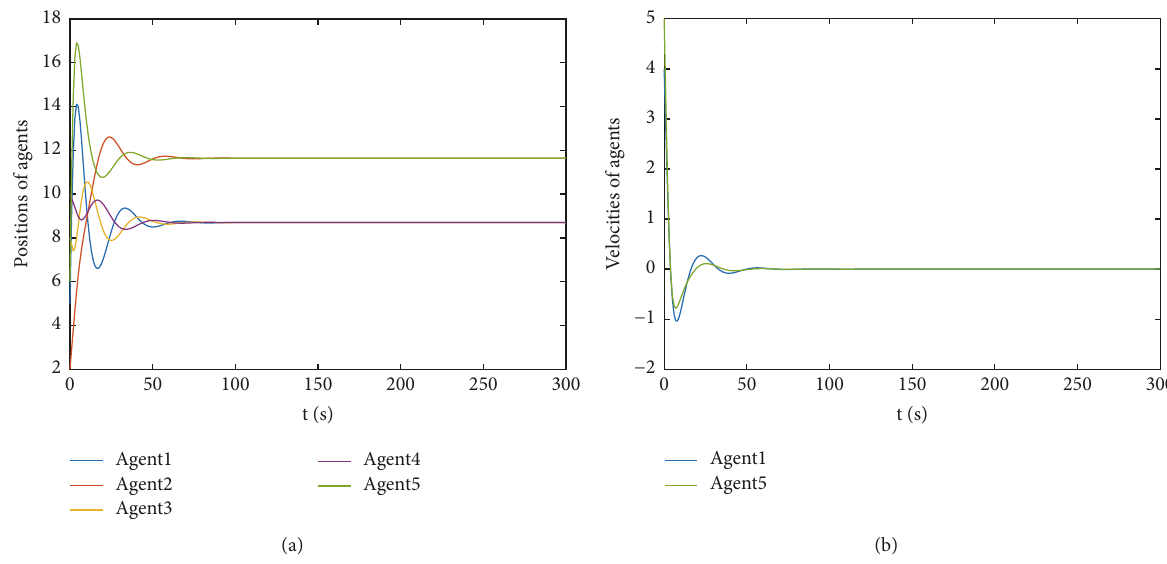
Figure 6: The state trajectories of the agents under directed topology in Figure 5 with identical input time delays 𝜏 = 1 , 𝜏 𝑖𝑗 = 1 . (a) Positions, (b)